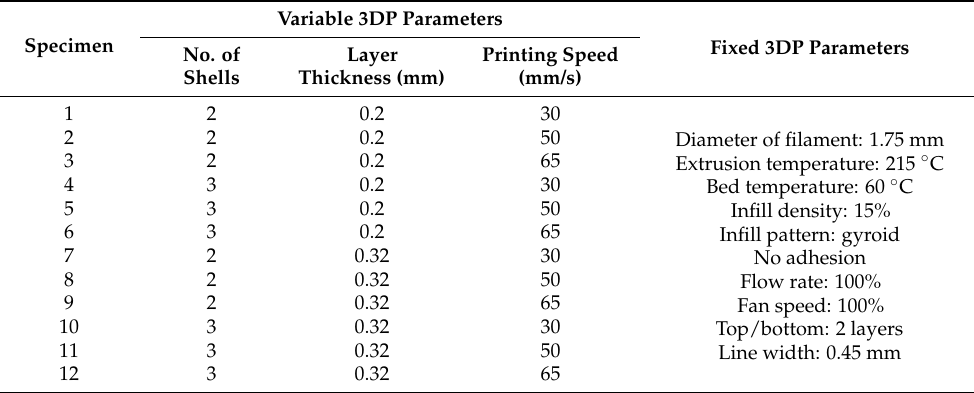
Table 1. 3DP parameter settings for the specimens built in experiment 1.